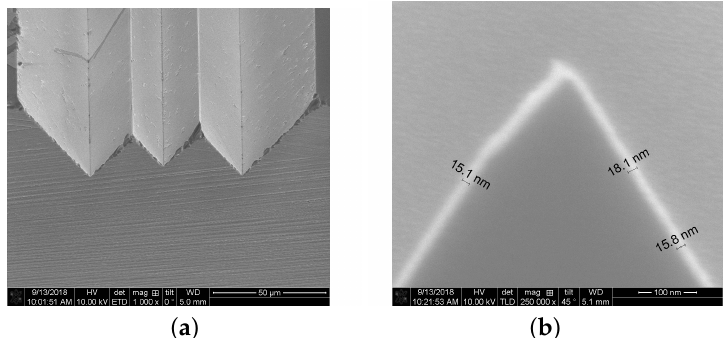
Figure 1. Scanning electron microscope (SEM) images of double-blade gold-coated silicon samples. ( a ) Photo at 100 micron scale and 45 degrees relative to the longitudinal direction. ( b ) Photo of transverse cross section at 100 nm scale. Note the lighter contrast corresponds to ≈ 15 nm thick gold